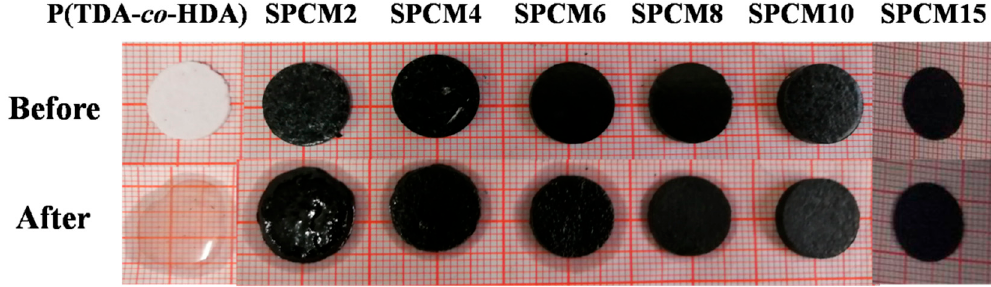
Figure 7. Photographs of P(TDA- co -HDA) and the SPCMs before and after the thermal treatment in an oven (60 °C, 30 min).